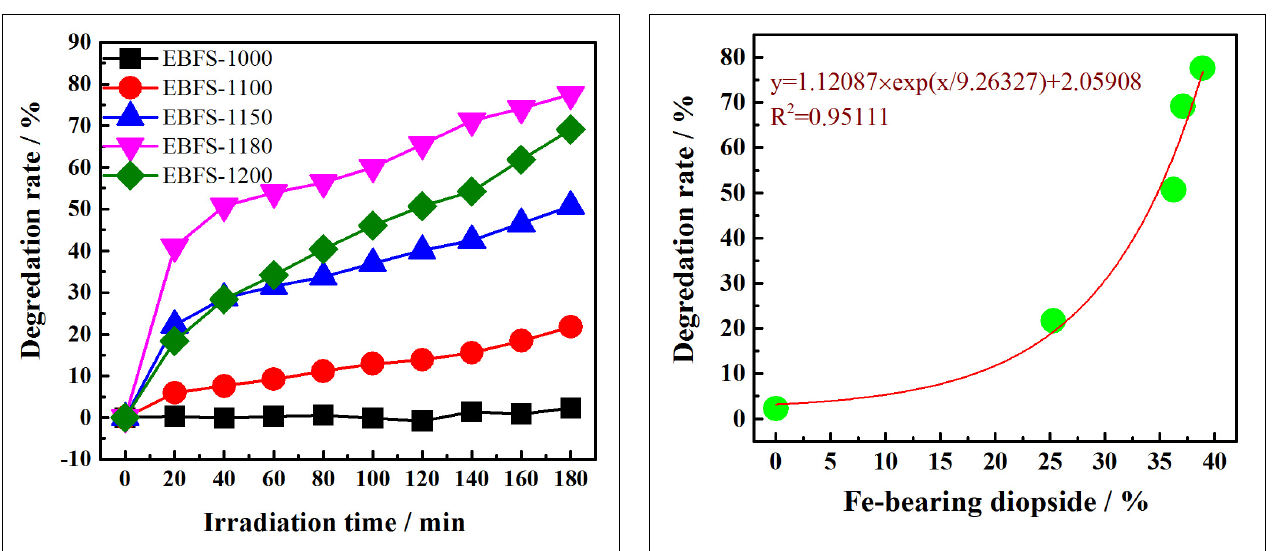
FIGURE 8 | Fe-bearing diopside contents versus degradation rates.